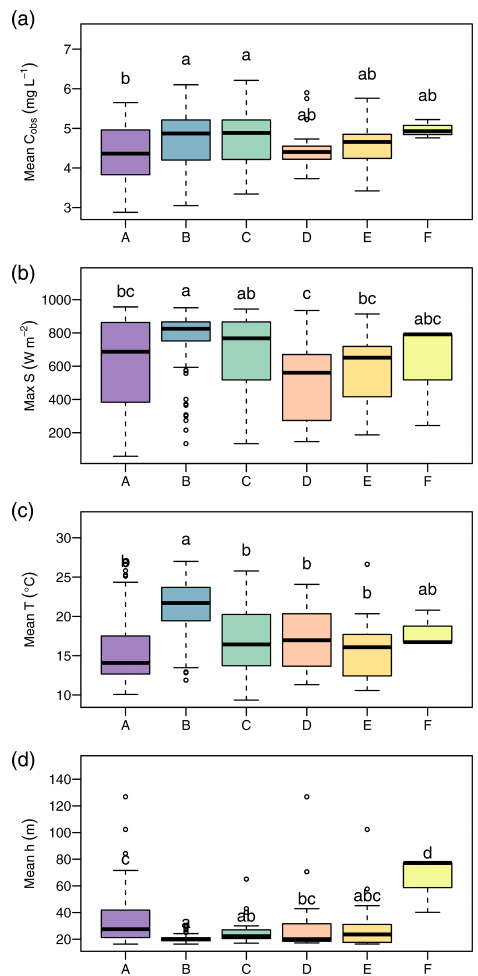
Figure 5. Environmental conditions during occurrence of clusters. The panels show daily average NO − concentration (a) , daily max- 3 imum of global irradiance (b) , daily average water temperature (c) , and daily average water level (d) . Lowercase letters above boxplots were assigned to groups that do not differ significantly according to analyses of variance (ANOVA) and Tukey